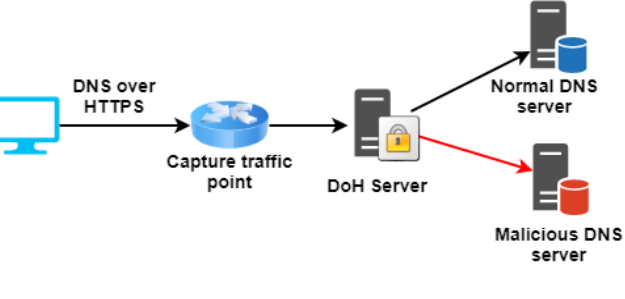
Figure 6. Raw DoH traffic capture. Table 2. List of the 34 statistical features extracted from captured traffic using CICFlowmeter.